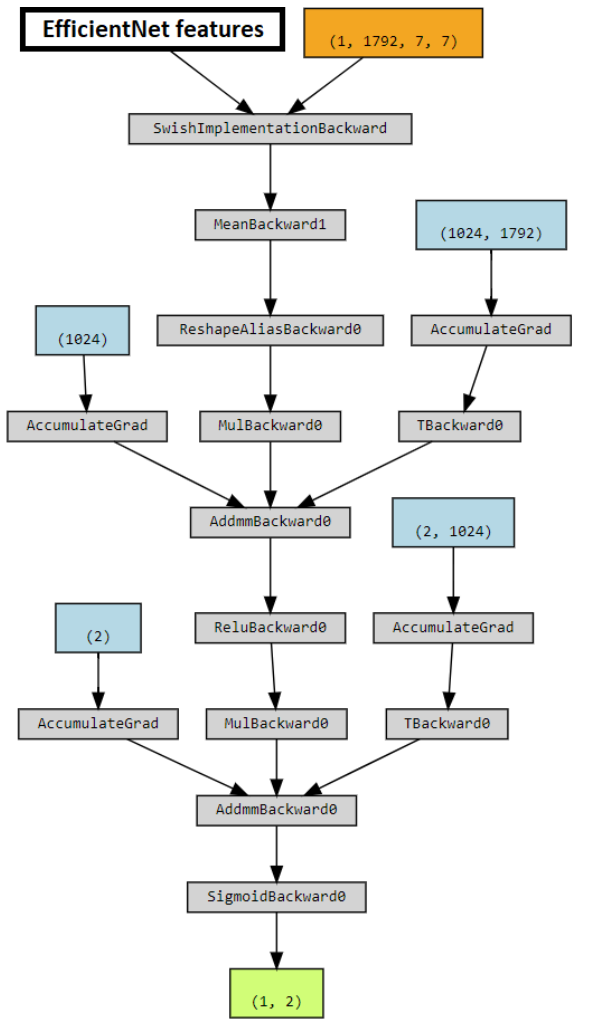
Figure 7. Model employed by the DC-GAN (Amped Team). The training was done using Pytorch (pytorch.org, accessed on 1 March 2022) and Pytorch Lightning (pytorchlightning.ai, accessed on 1 March 2022) frameworks with two RTX 2080 Ti GPUs. Participants used the Adam optimizer, with an initial learning rate